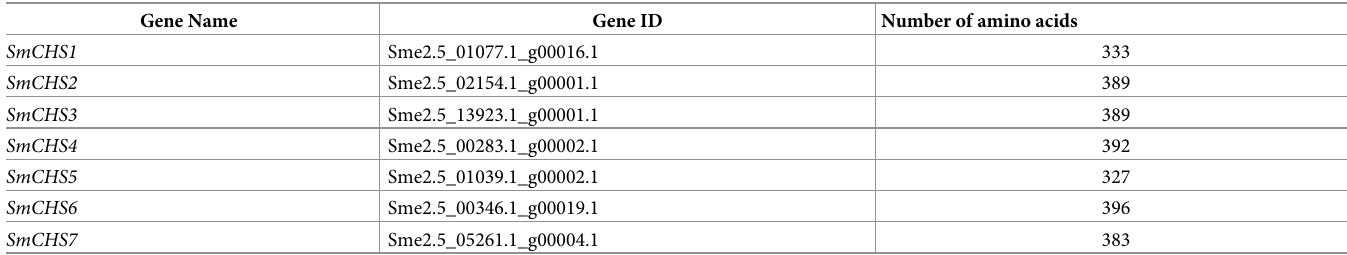
Table 1. Features of SmCHS genes identified in eggplant.